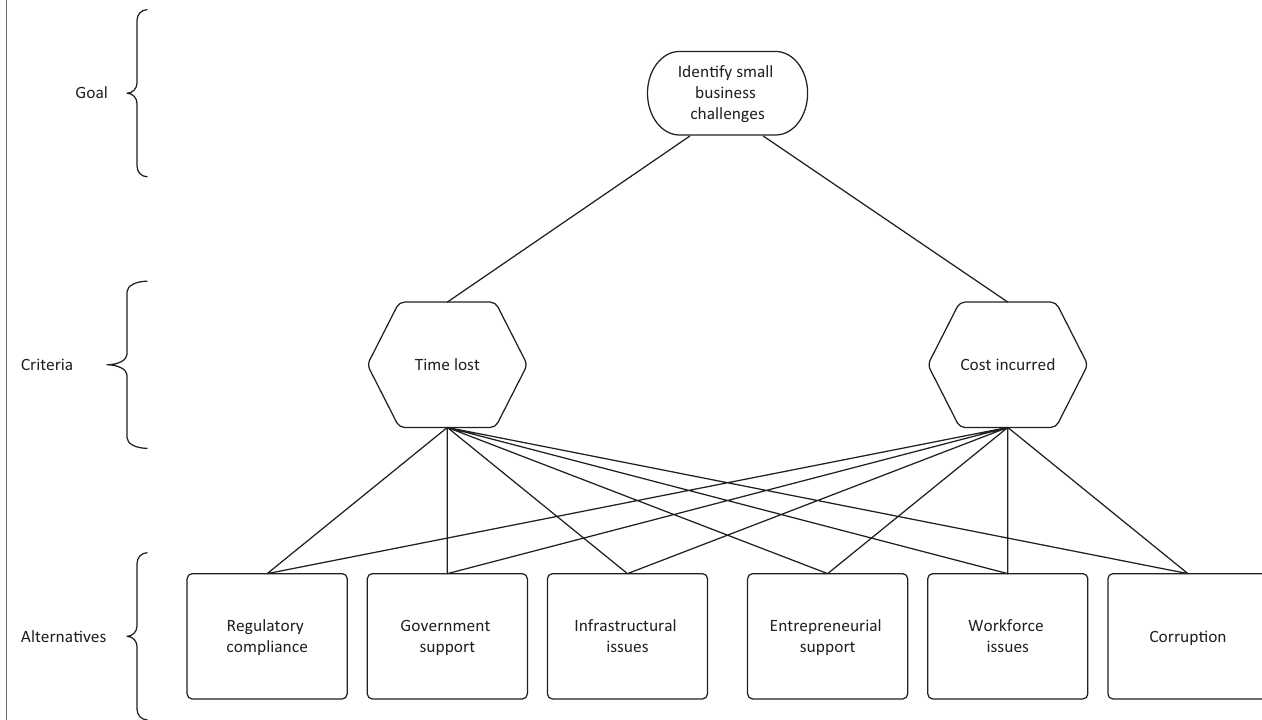
FIGURE 3: Analytical hierarchy process diagram for small-business